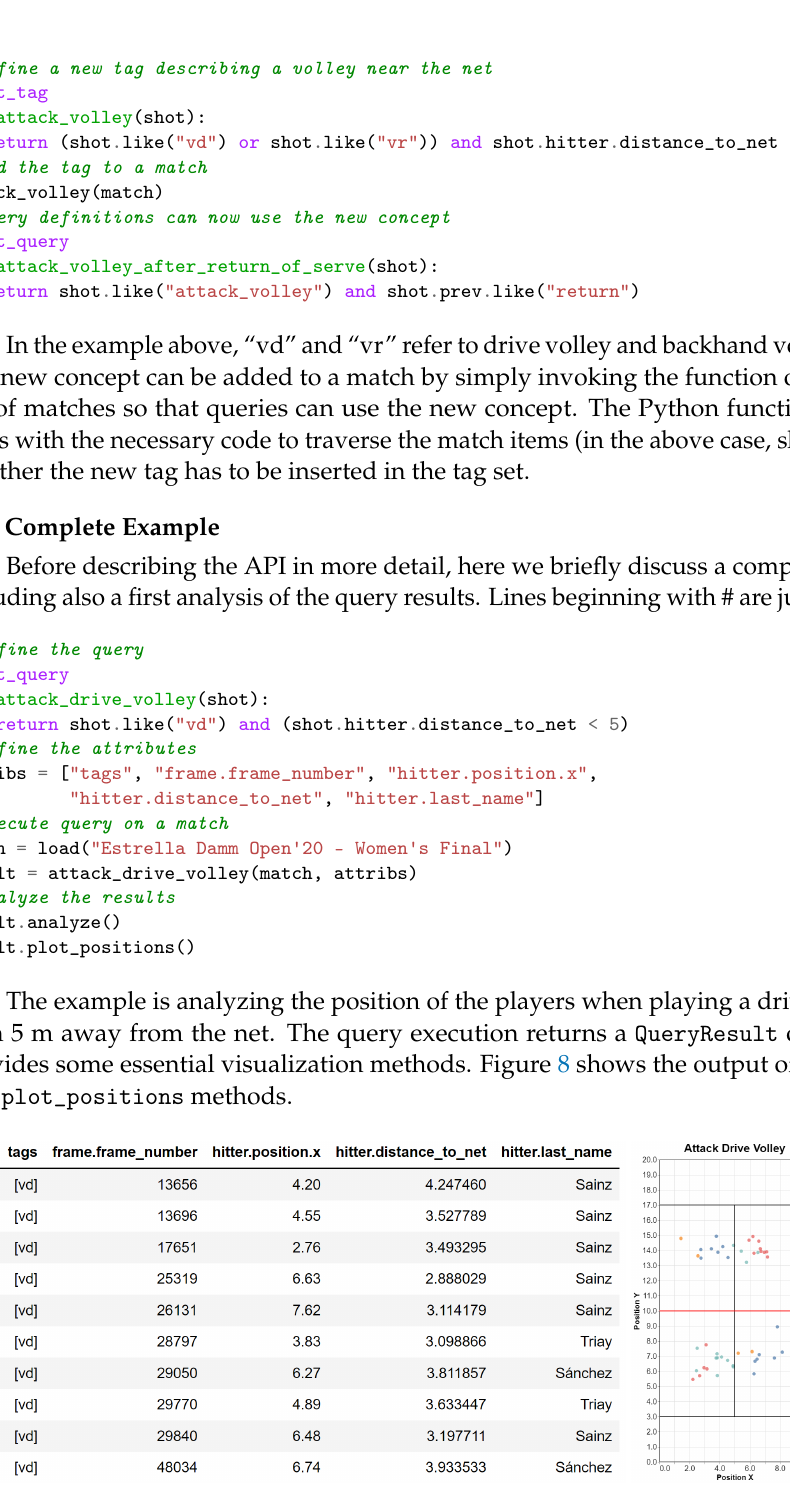
Figure 8. Output from the execution of a query on drive volleys less than 5 m away from the net. We only show the first rows of the output